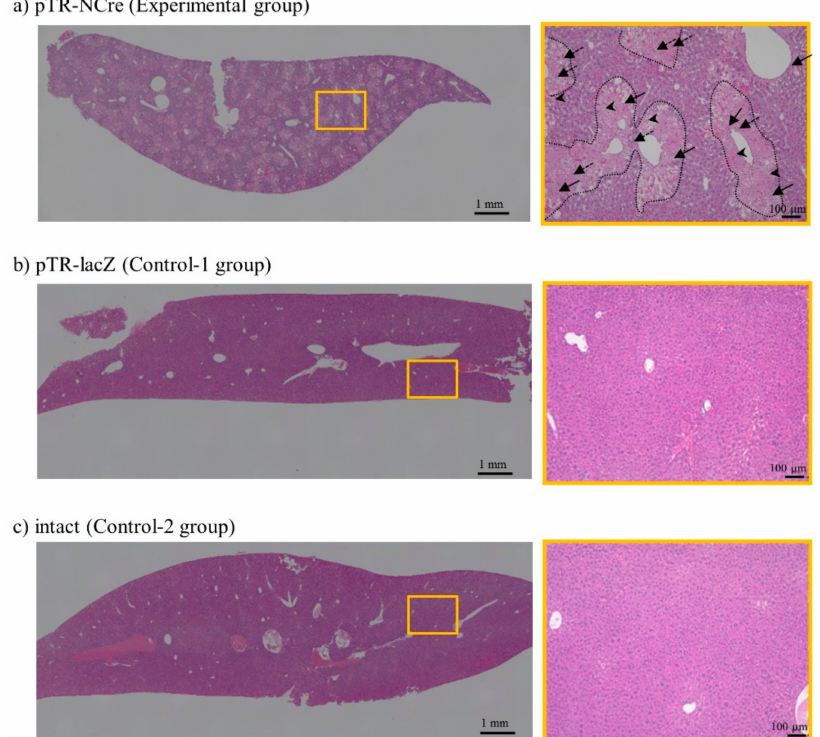
Figure 4. Hydrodynamics-based gene delivery and PB transposon system enable the creation of disease models for liver dysfunction. Pathological analysis of the pT-CETD-incorporated females assayed 28 days after the second HGD with pTR/NCre (experimental group) or pTR/lacZ (control-1 group). These data are representative of three animals. Left panels , low-magnification images of dissected liver from mice (#1) in the experimental ( a ), and control-1 ( b ), and -2 groups ( c